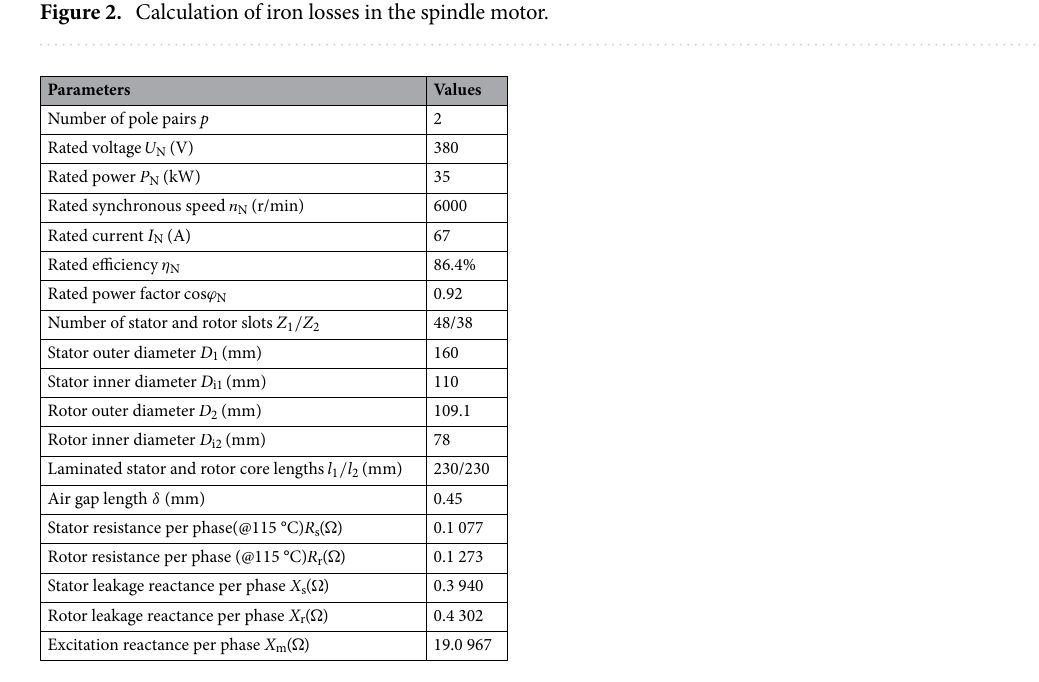
Table 1. Specifications of the spindle